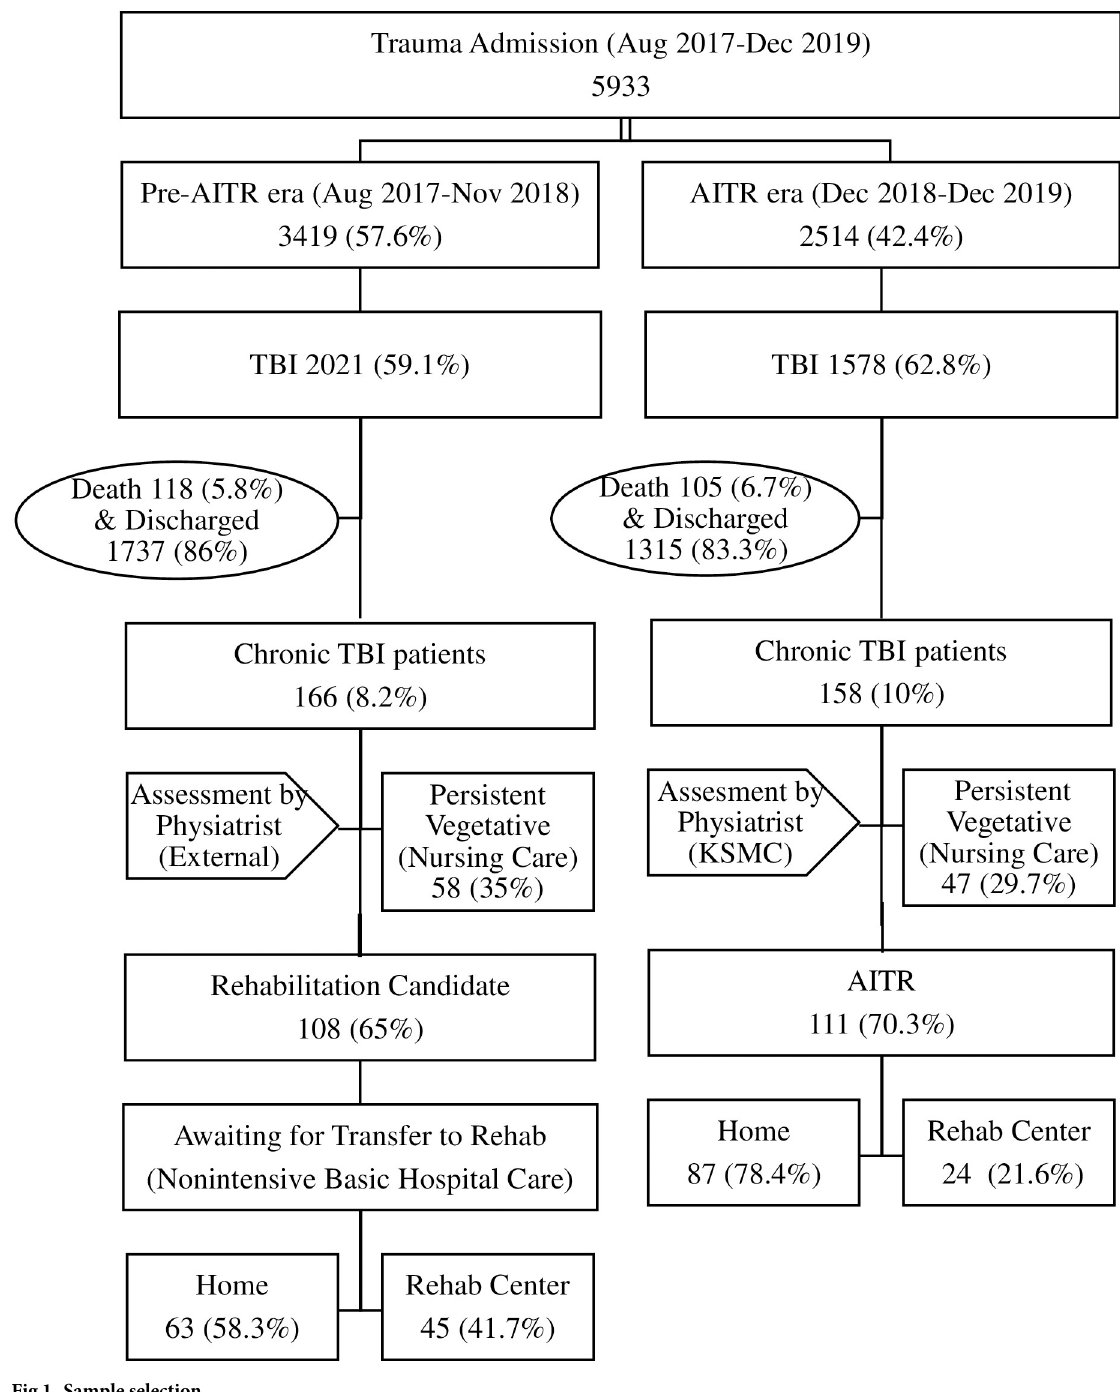
Fig 1. Sample selection.